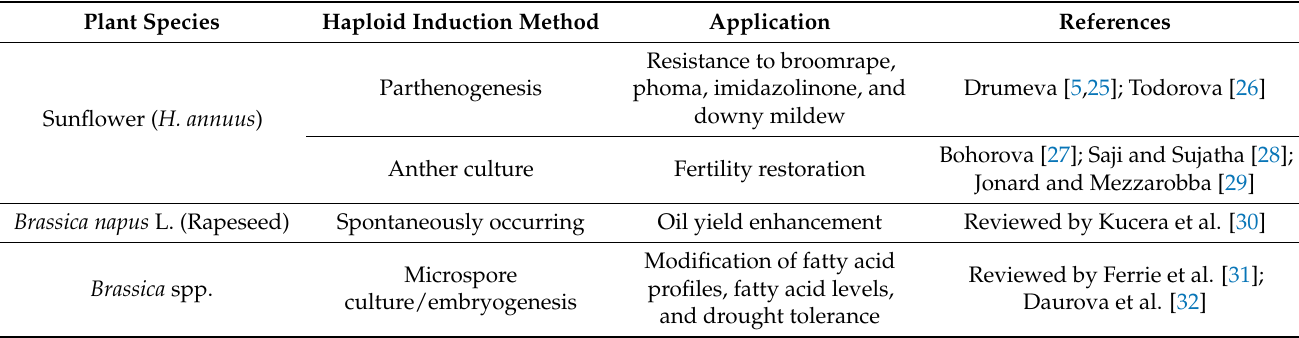
Table 1. Doubled haploid induction methods used in oilseed